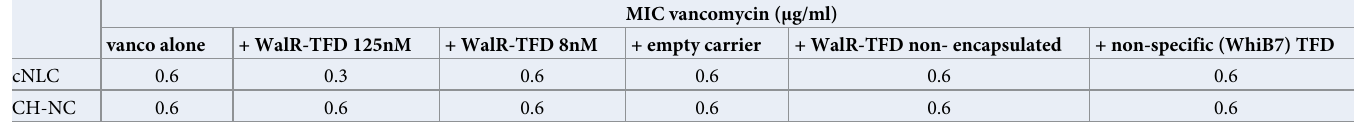
MIC vancomycin ( μ g/ml)